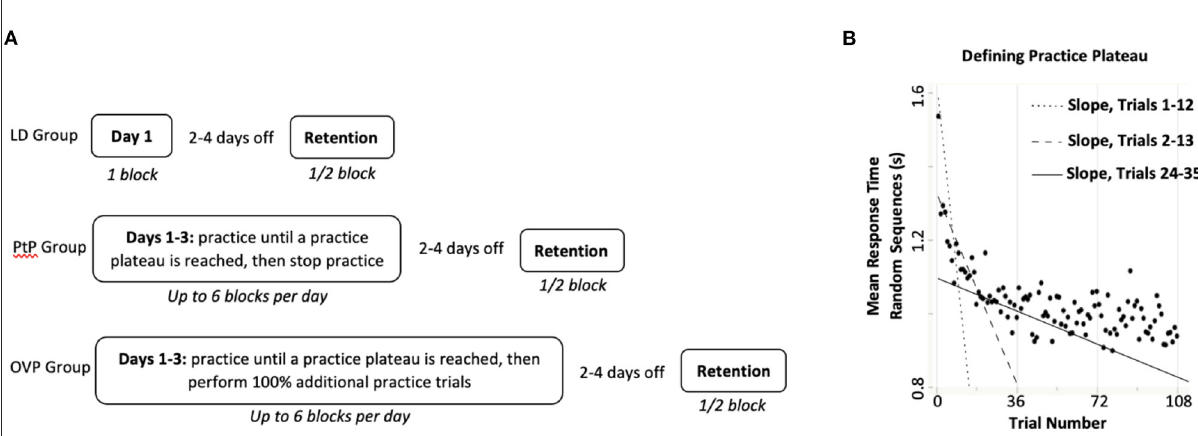
FIGURE2 (A) Practice and retention testing timeline for each group. LD, Low Dose group; PtP, Practice to Plateau group; OVP, Overpractice group. Participants randomly assigned to the LD group completed 1 block of 6 trials of task practice over one training day, while those in the other two groups performed up to 6 blocks of practice per day for several days. Specifically, people in the PtP group practiced the task until they achieved a practice plateau (between 1 and 3 training days), at which point they stopped practicing; participants in the OVP group performed 100% additional practice trials after reaching a practice plateau (between 1 and 3 total training days). The retention test occurred following 2–4 days of no practice. (B) A hypothetical illustration of how iterative slopes are calculated for a participant, in order to determine their practice plateau. A scatterplot (solid circles) of mean response time on the random sequences of the SRTT ( y -axis) is shown as a function of practice trial number ( x -axis). Using Ordinary Least-Squares Regression, a slope is calculated for Trials 1–12. Iterative slopes are then calculated immediately after each additional trial is completed, for Trials 2–13, Trials 3–14, Trials 4–15, Trials 5–16, etc. Generally, successive slopes become less steeply negative (i.e., flatter) as the participant practices, as illustrated by the three exemplar slope lines shown. Iterative slopes continue to be calculated until the participant is found to have reached a practice plateau. A slope of > -0.001 was considered to be little-to-no improvement on the task and each participant was considered to have reached a practice plateau after custom-coded software calculated seven consecutive slopes greater than